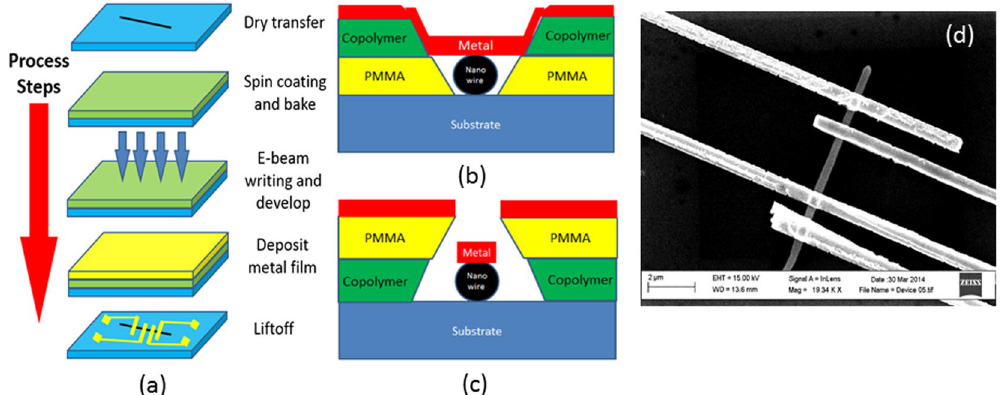
Figure 4. Fabricating process of the single wire devices. ( a ) Process steps for fabricating a single nanowire into four electrodes devices via e-beam lithography. Double layer configuration ( b ) with copolymer layer (slower develop speed) on the top formed an inverted trapezoid structure and ( c ) with PMMA layer (faster develop speed) on the top formed a trapezoid structure. ( d ) SEM image of a successful prepared four probe